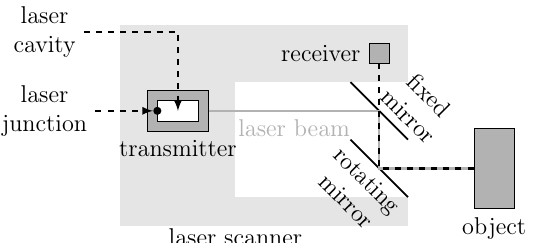
Figure 1. Graphical description of the operating principle for pulsed ToF LiDARs. A pulsed infra-red laser beam is first emitted from the transmitter. The case of the transmitter, in dark gray, encloses a laser junction and a laser cavity. The emitted laser beam is then deflected by a rotating mirror (resulting in a fan-shaped scan pattern) and, finally, reflected from the object surface. The time of flight τ between the transmission and the reception of the laser beam is then used to estimate the distance d between the scanner and the object.